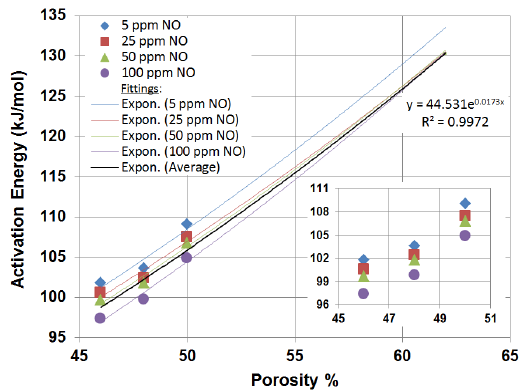
Figure 6. Experimental activation energies vs. sensor porosity with exponential